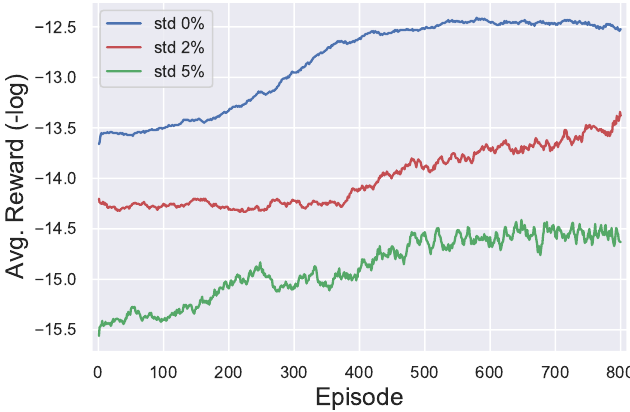
Figure 10. A figure shows cumulative rewards over training episodes in different PE variations. The reward scale is represented in negative log scale. The agent starts training from pseudo-steady-state, and uses simple input profile and 50 scale